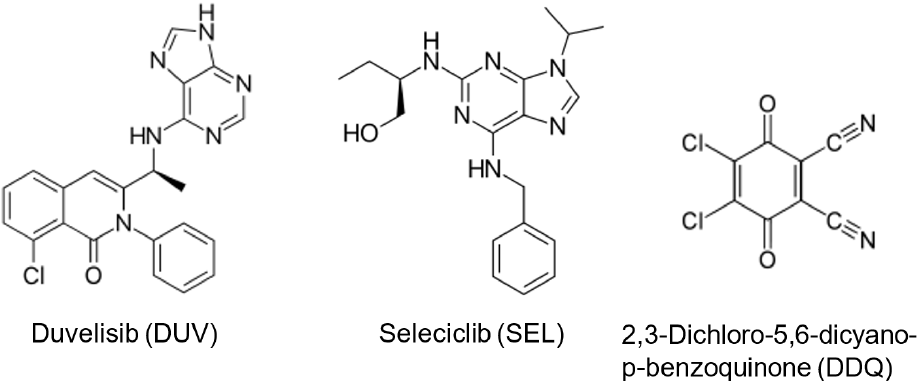
Figure 1. The chemical structures of duvelisib (DUV), seleciclib (SEL), and 2,3-Dichloro-5,6-dicyano- p-benzoquinone (DDQ).